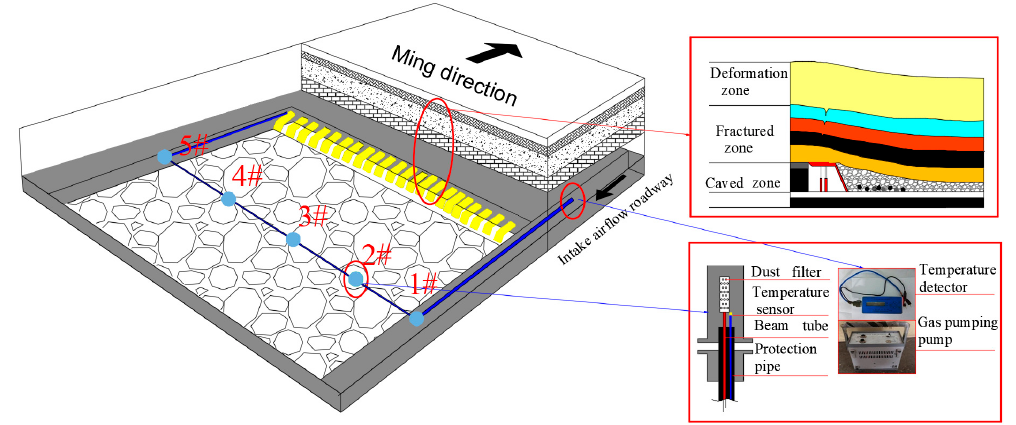
Figure 8. Schematic diagram of the 1105 working face measuring points.